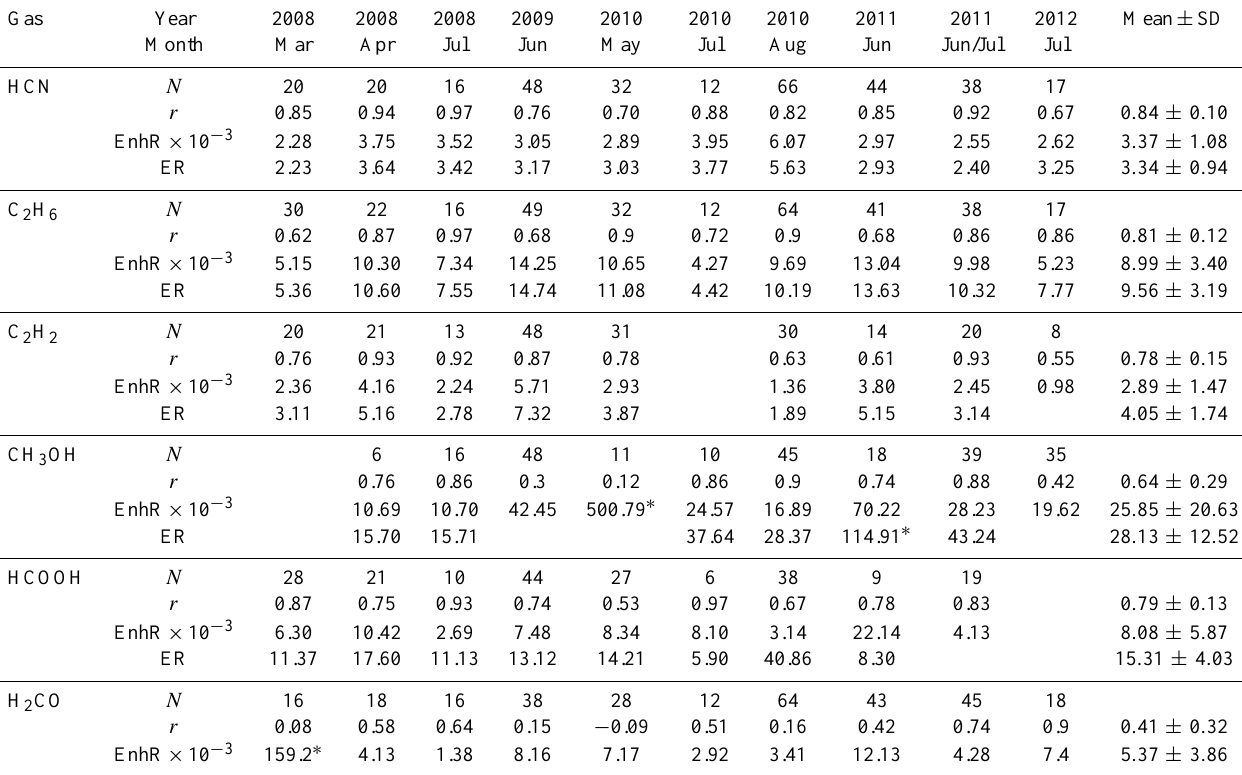
Table 5. Correlation between each trace gas and CO inside the smoke plumes detected over Eureka. N is the number of points, r is the coefficient of linear correlation and EnhR is the enhancement ratio, which is the slope derived from the correlation. For all gases except H 2 CO, ER represents the corrected enhancement ratios from travel time calculated only if the linear correlation coefficient ( r> 0 . 6) and the number of points ( N> = 6). ∗ Values excluded from the mean